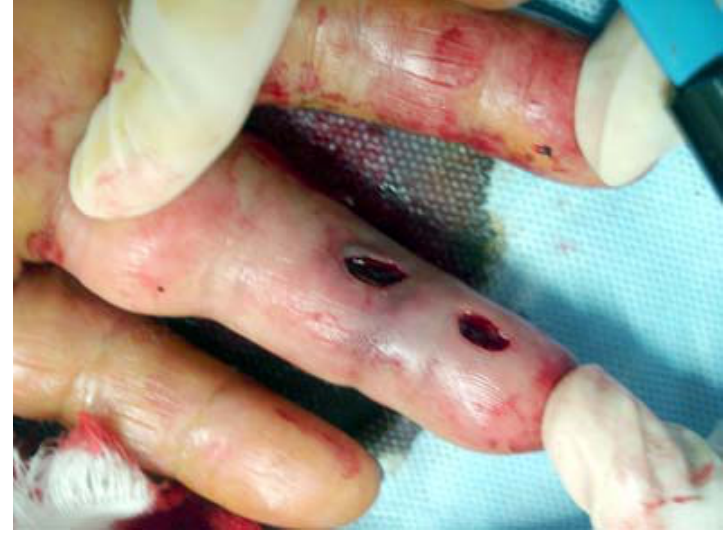
Figure 8. Necrotic soft tissue was immediately